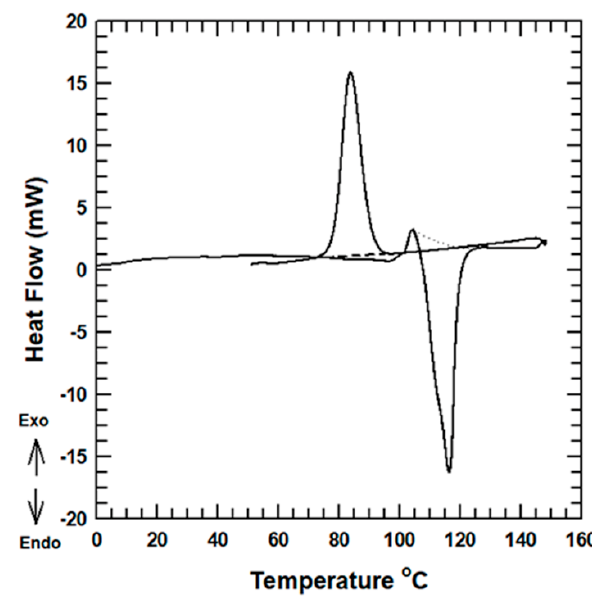
Figure 5. DSC thermograph curve of the neat PBS. Table 1. Crystallization and melting behavior of neat PBS and its